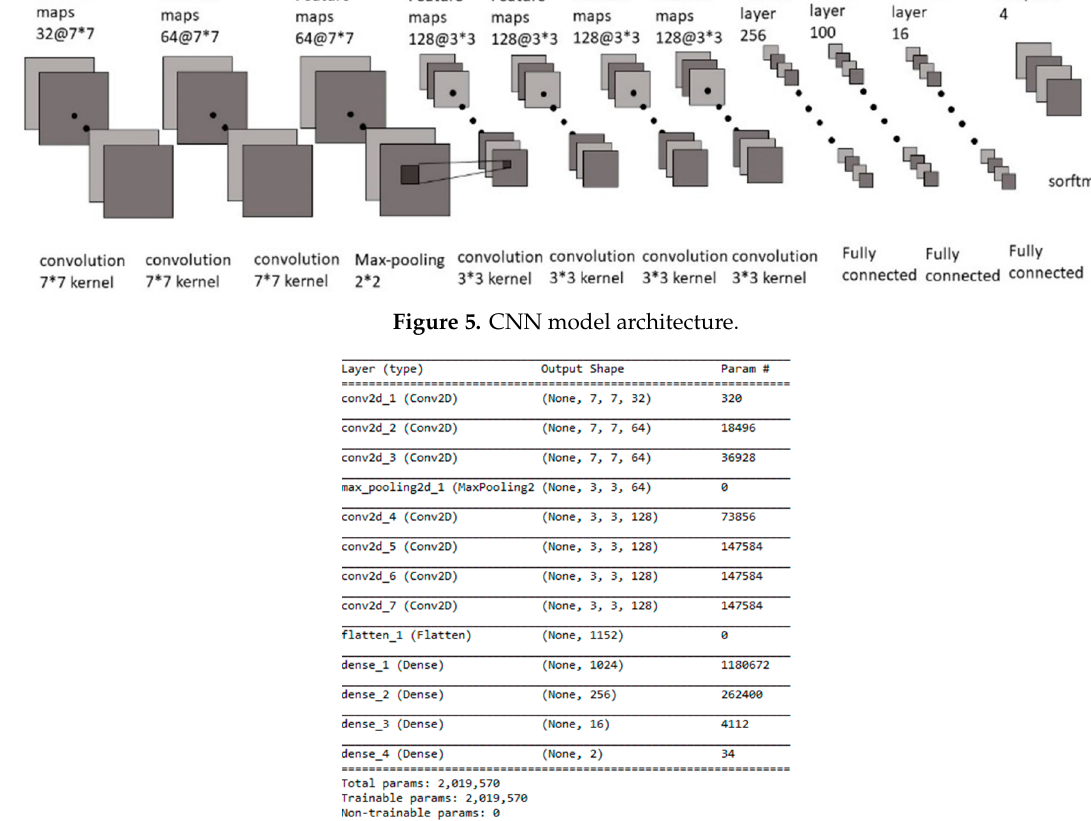
Figure 6. Our proposed CNN architecture.